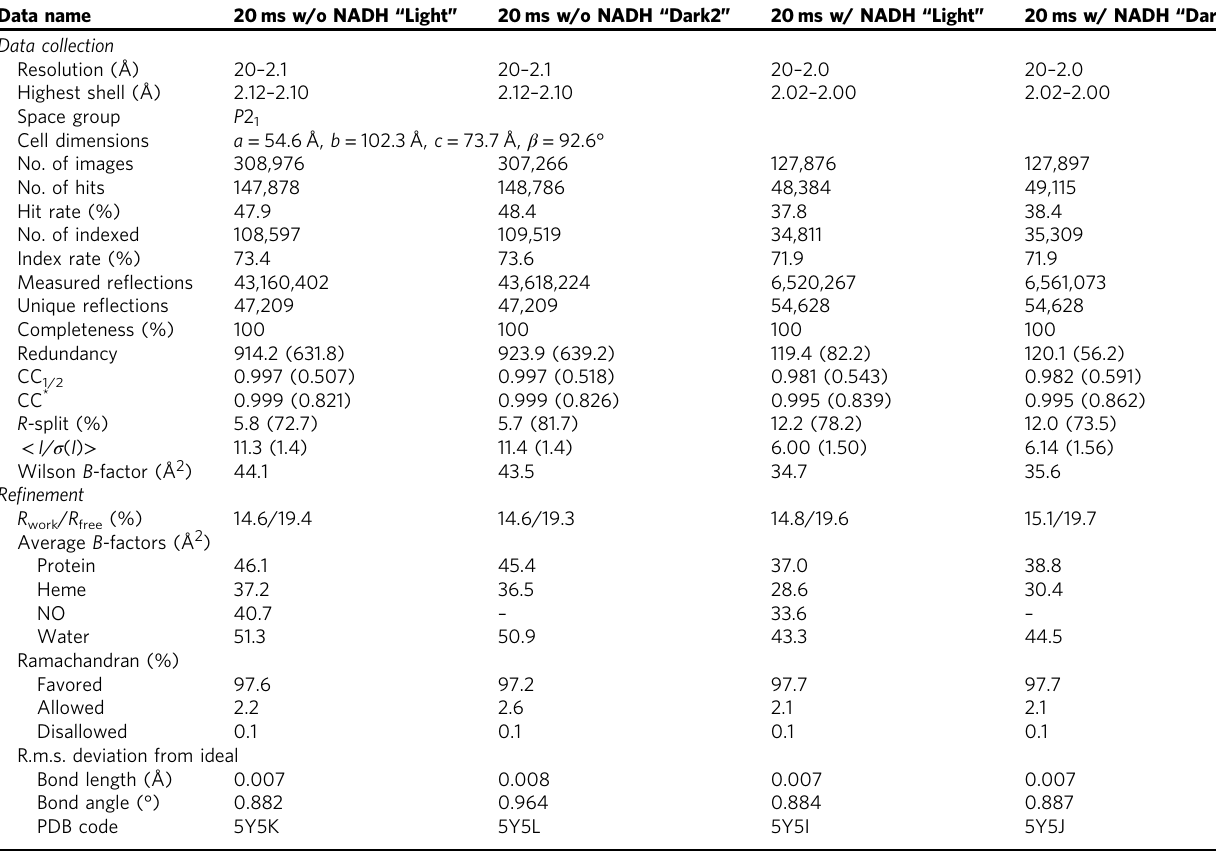
Table 2 Statistics for TR-SFX intensity data collection and structure re fi nement Data